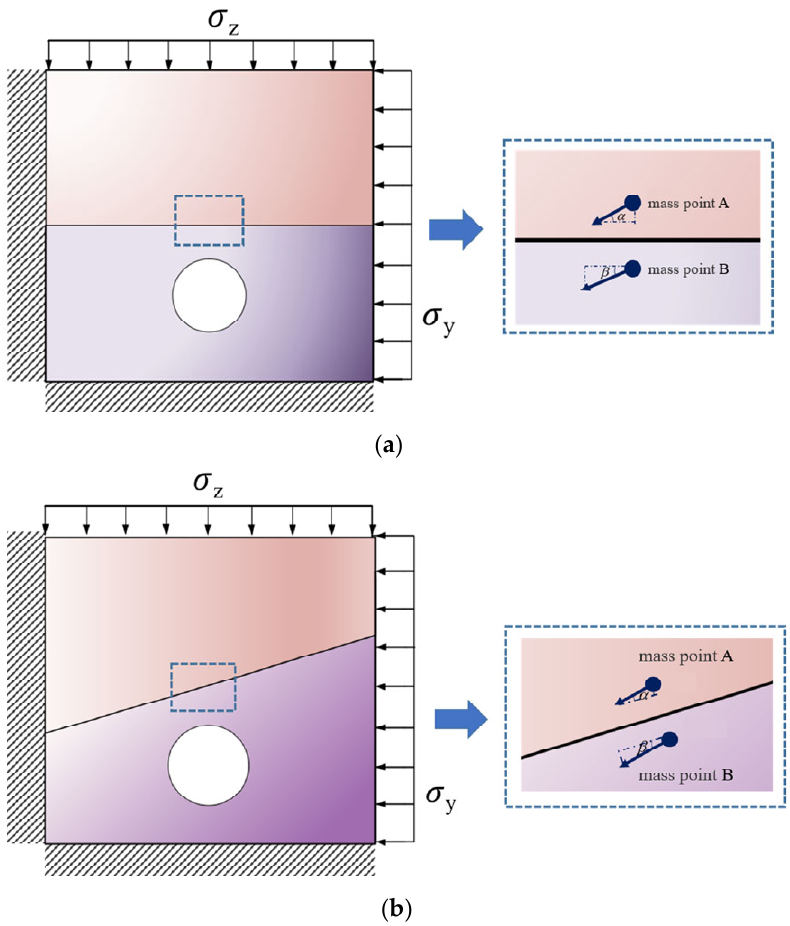
Figure 8. Loading mode diagram and sliding along the fracture plane for granite samples: ( a ) A ‐ 0; ( b ) A ‐ 30.